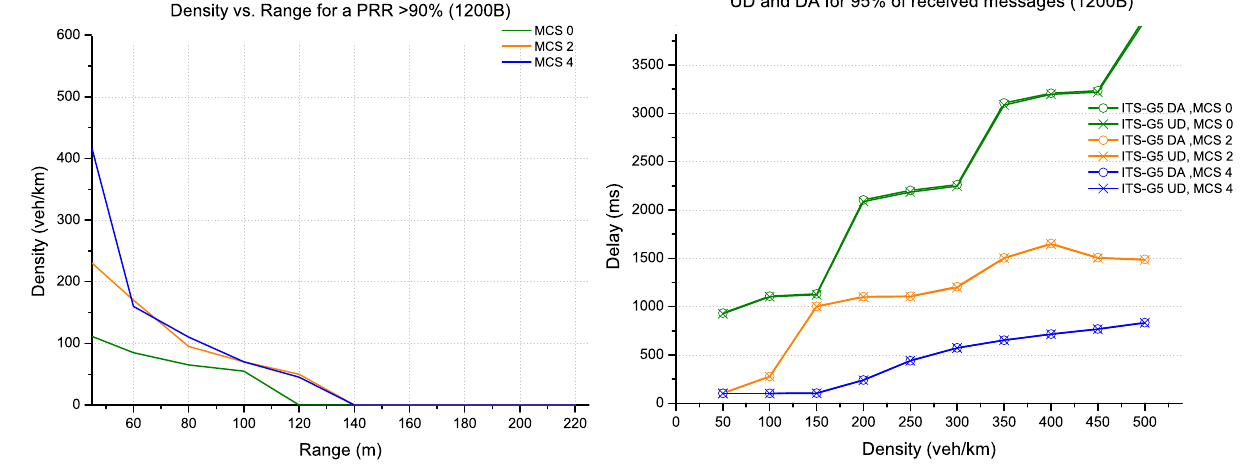
Figure 6. Evaluation for ITS-G5 technology (packet size 1200